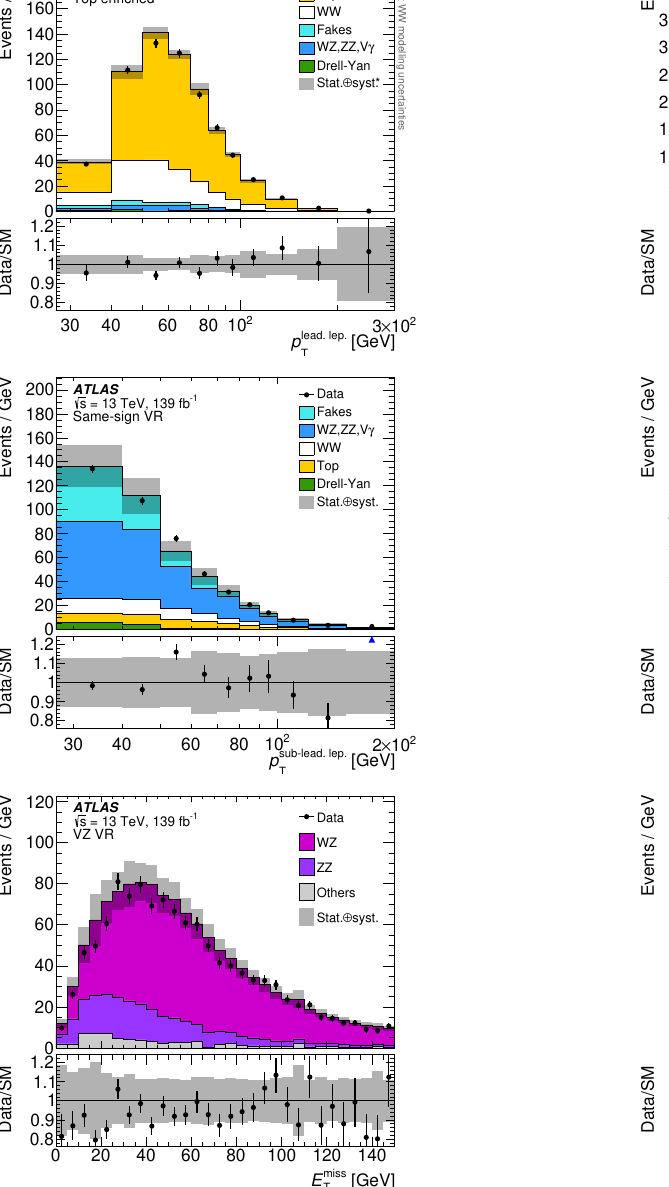
(top left) and the jet multiplicity (top Figure 2 . Detector-level distributions of the p lead. lep. T right) in the top-enriched region, the p sub-lead. lep. in the same-sign validation region (VR) (middle T left), the m in the Drell-Yan VR (middle right), the E miss in the V Z VR (bottom left), and the eµ T electron candidate p in the V γ VR with opposite-sign leptons (bottom right). The last bin contains T overflow events. Data are shown as black markers, together with the predictions for the signal and background production processes. The top background in the top-enriched region is estimated using the data-driven method explained in the text; in all other regions the nominal MC prediction is used. The lower panels show the ratio of the data to the total prediction. The uncertainty bands shown include statistical and systematic uncertainties, excluding theory uncertainties on the